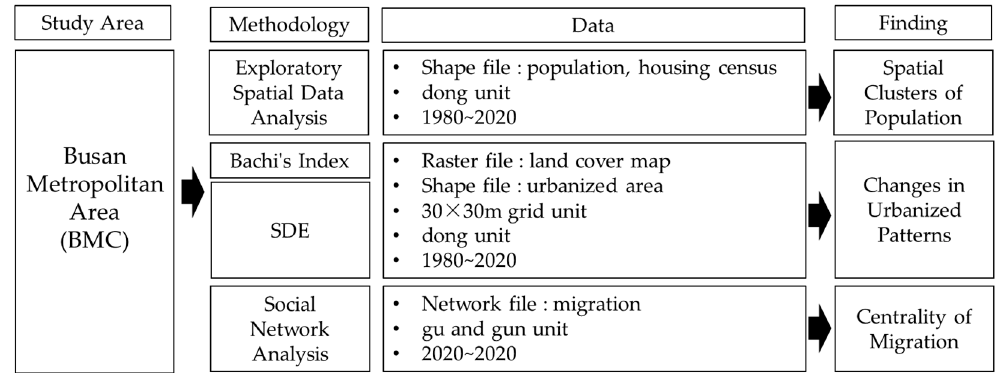
Figure 2. Analytic